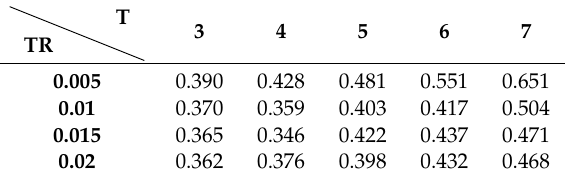
Table 4. Average runtimes of di ff erent slope numbers and di ff erent range thresholds. T TR